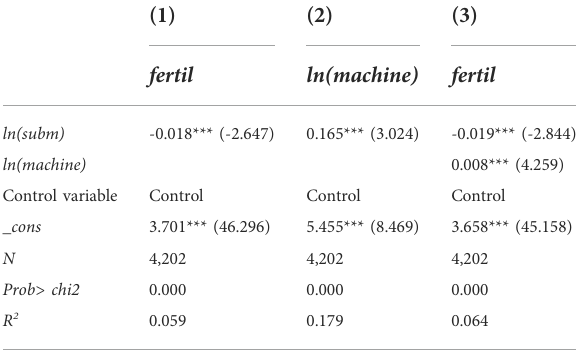
TABLE 6 Mediating effect of farm machinery